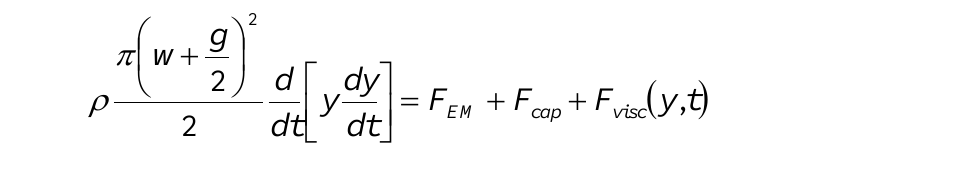
Figure 2. (a) Equivalent electric circuit of a LDEP actuation device. (b) Scheme describing liquid actuation using LDEP and forces acting on the